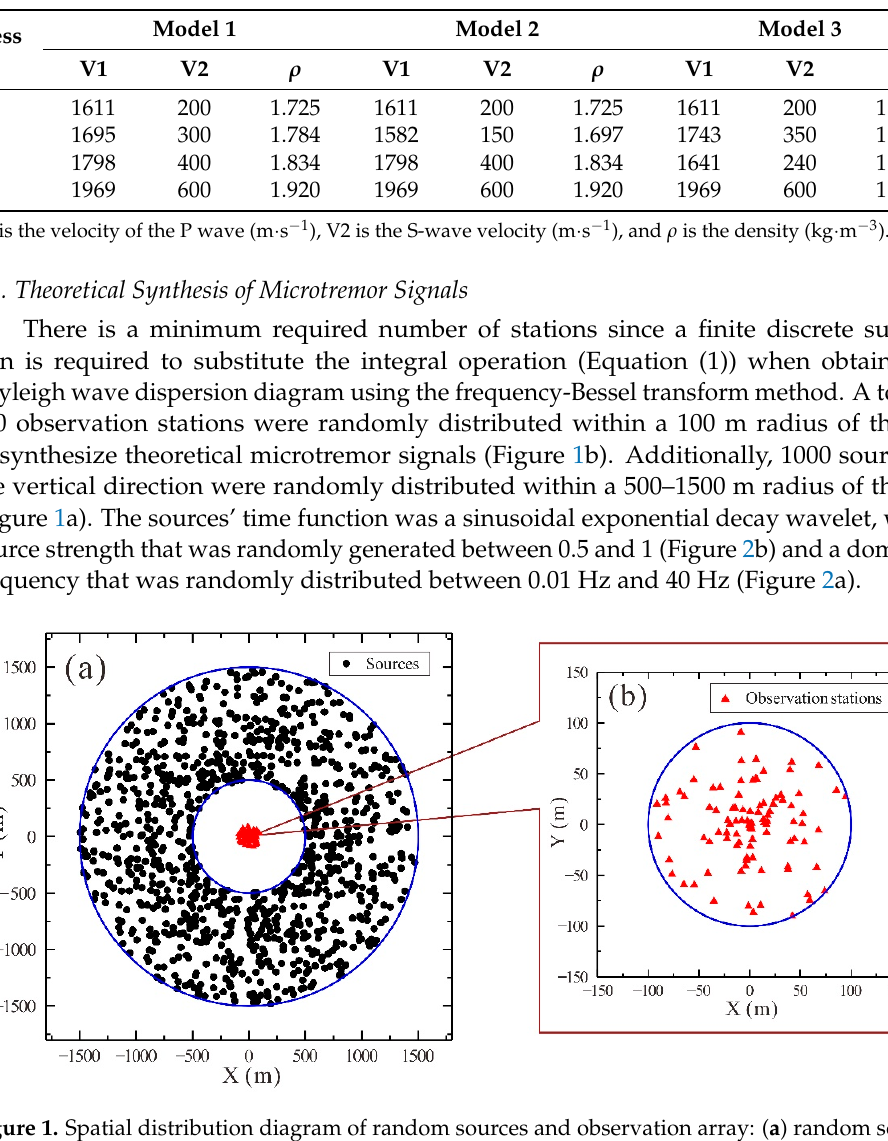
Figure 2. Theoretical synthesis of microtremor signals: ( a ) histogram of dominant frequency distri- bution of sinusoidal exponential decay wavelet; ( b ) source strength distribution histogram; ( c ) dis- tribution histogram of source wavelet take-off time; ( d ) waveform diagram of microtremor signals of 20 stations synthesized by model 1. 3.3. Microtremor Signal Processing In this study, the synthetic theoretical microtremor signals were processed using the frequency-Bessel transform method. The computed frequency range must be supplied to calculate the Rayleigh wave dispersion diagram. Since the dominant frequency of the source wavelet was randomly distributed in the range of 0.01–40 Hz, this paper only cal- culated a Rayleigh wave dispersion diagram with the frequency range of 0.2–40 Hz. The stations in this study were first paired, and the cross-correlation functions of each group of stations were then determined. Then, the frequency-Bessel transform was applied to the resulting cross-correlation function over an acceptable range of phase velocity